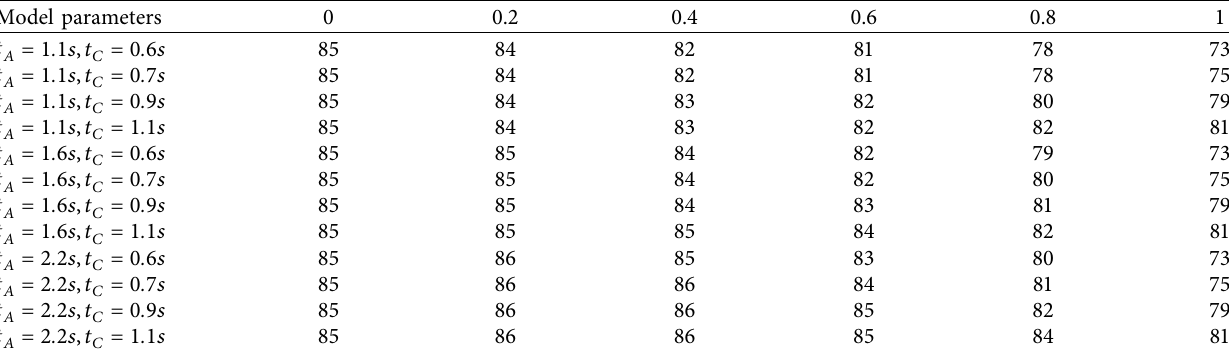
Table 6: Maximum congestion delay under different model parameters (unit: vehs). Model parameters